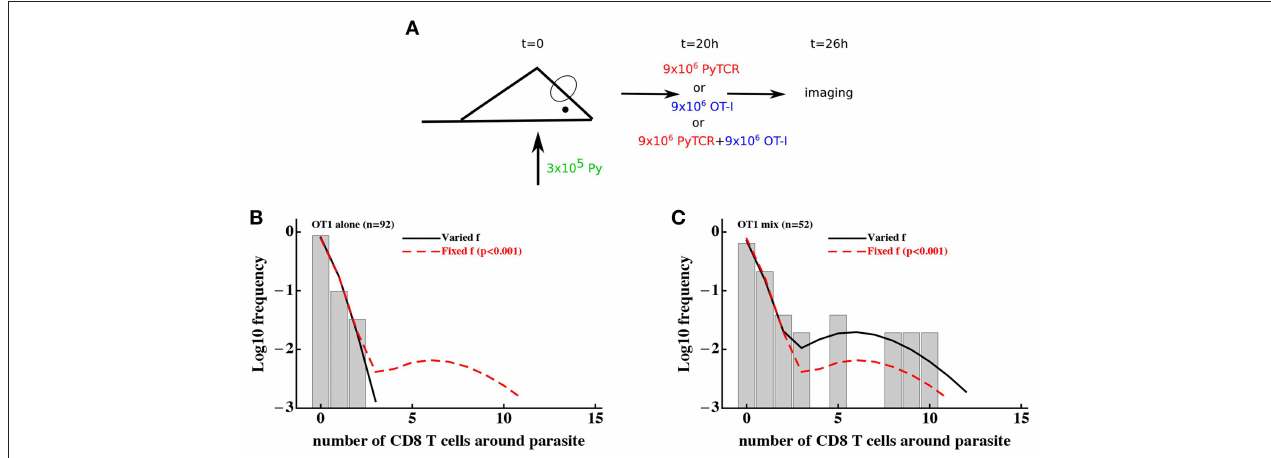
FIGURE 4 | Models assuming time-invariant but spatially-variable environment are unable to accurately describe the clustering of T cells of irrelevant specificity in different conditions. (A) Mice were infected with 3 10 5 GFP-expressing Py sporozoites. Twenty hours later 9 10 6 Py-specific activated CD8 T cells (PyTCR), × × 9 10 6 OT1 T cells (specific to chicken ovalbumin), or mixture of 9 10 6 PyTCR and 9 10 6 OT1 T cells were transferred into infected mice and livers of these mice × × × were imaged using intravital microscopy 6 h later. In total 92 (mice receiving only OT1 cells, B ) and 52 (in mice receiving a mix of PyTCR and OT1 cells, C ) parasites were randomly chosen and the number of T cells in a 40 µ m radius were counted ( 29). The “two population” mathematical model (Equation 10) was fitted to these two datasets simultaneously assuming two different entry rates θ 01 and θ 02 and either allowing the fraction of attracting parasites f to vary between the datasets (solid line) or to be fixed between the datasets (dashed line). Fixing the fraction f between the datasets significantly reduced the quality of the model fit of the data as compared to the model in which f could vary (likelihood ratio test, χ 2 1 12.4, p < =